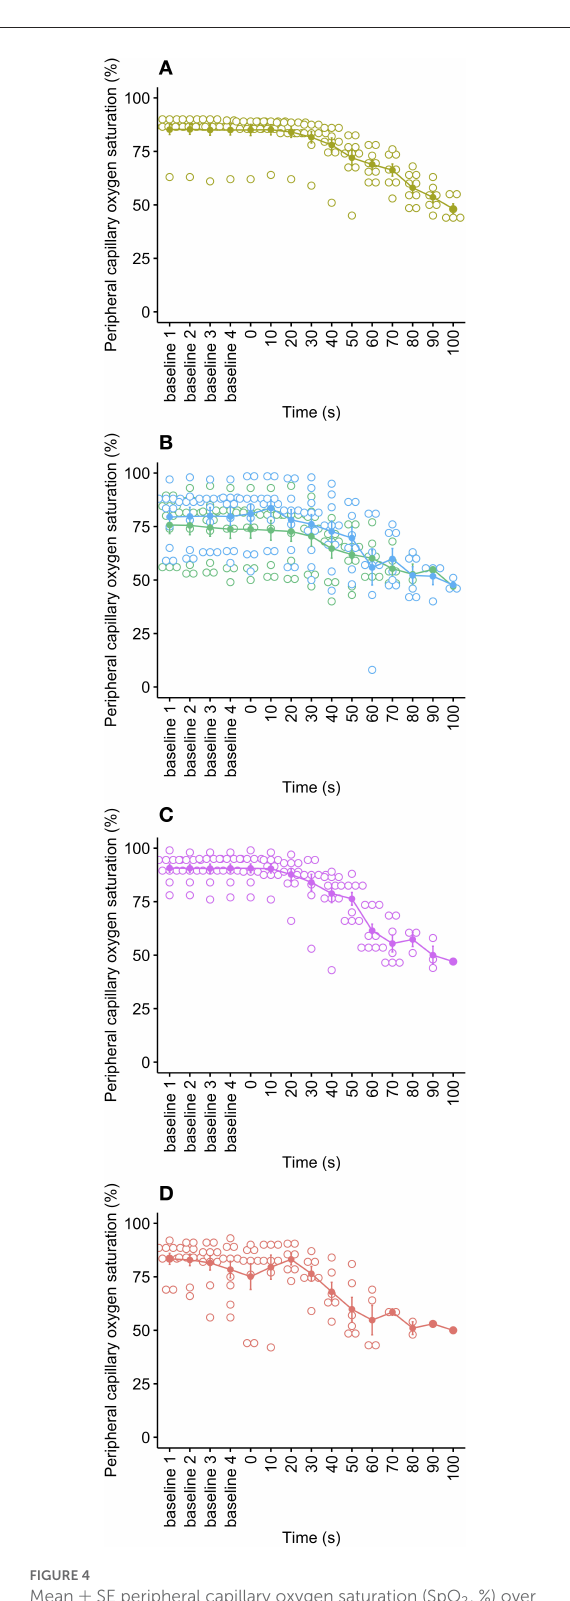
FIGURE4 Mean ± SE peripheral capillary oxygen saturation (SpO 2 , %) over time for each decompression treatment rate: (A) 40 ms −